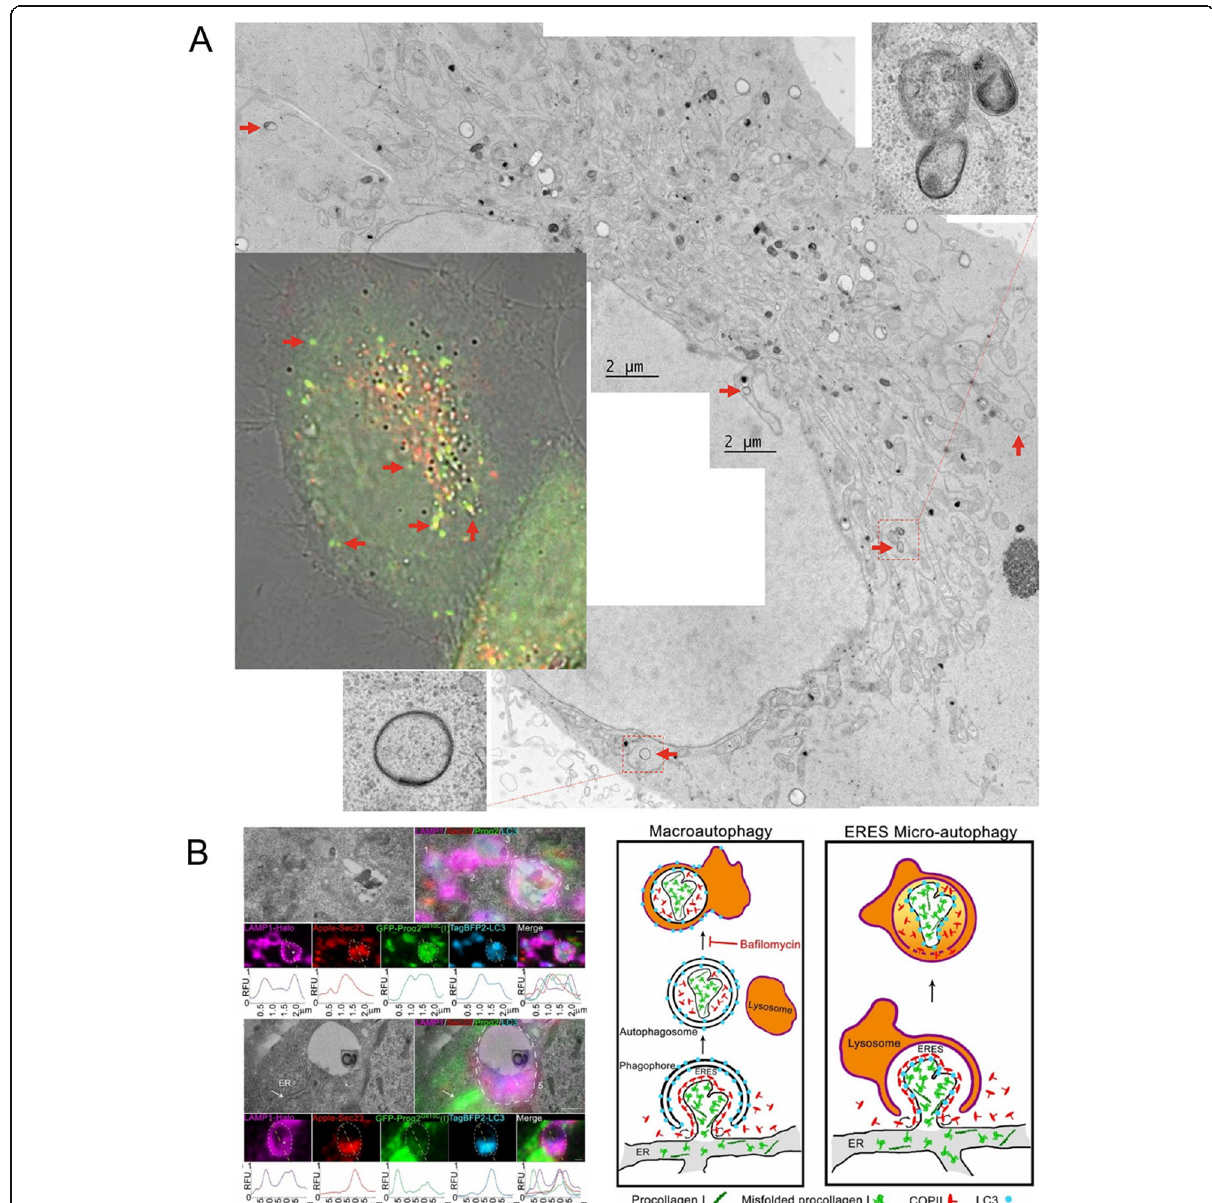
Fig. 2 Example of correlative light and electron microscopy of autophagosomes. a The red arrow indicates the corresponding structure between the fluorescence image and the electron microscope image. The higher magnification inserted images show that the morphology of the autophagosomes. b Ultrastructure and correlative image of ERESs engulfed by lysosomes and proposed noncanonical ERES microautophagy model. Reproduced with permission from the Springer Nature (Gudmundsson et al. 2019) and Proceedings of the National Academy of Sciences (Omari et al.